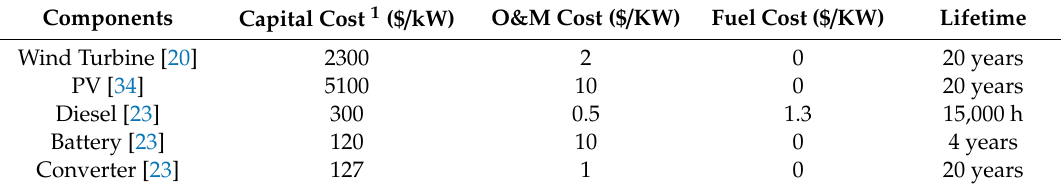
Figure 20. Pathways towards the optimal solution by the PSO model.